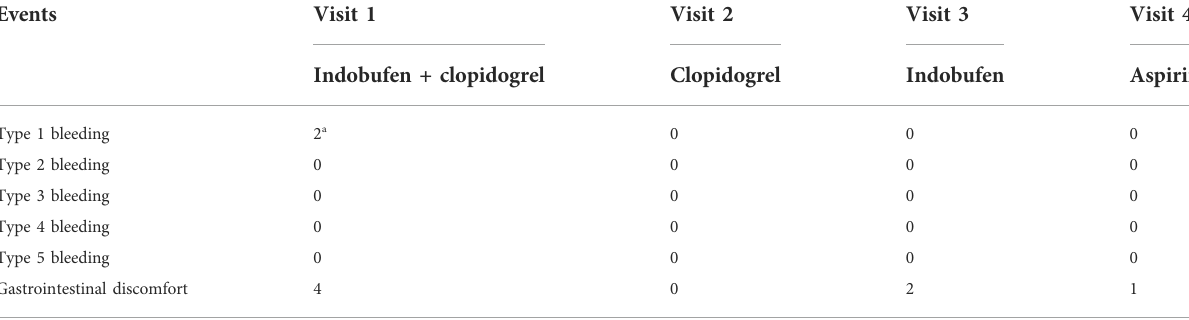
TABLE 2 Bleeding events and gastrointestinal discomfort during the study